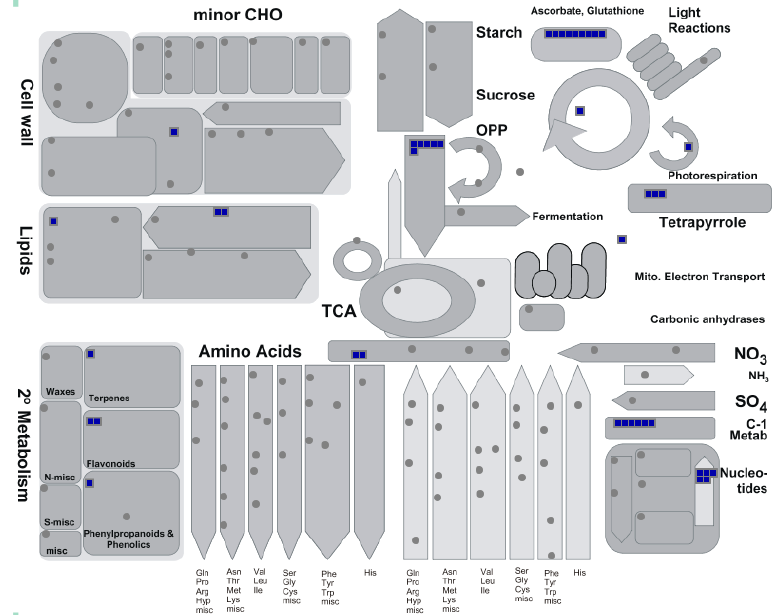
Figure 7. MapMan display for heat stress response (HSR) genes in LM11 and CML25. HSR genes involved in different biological functions are represented in blue color.